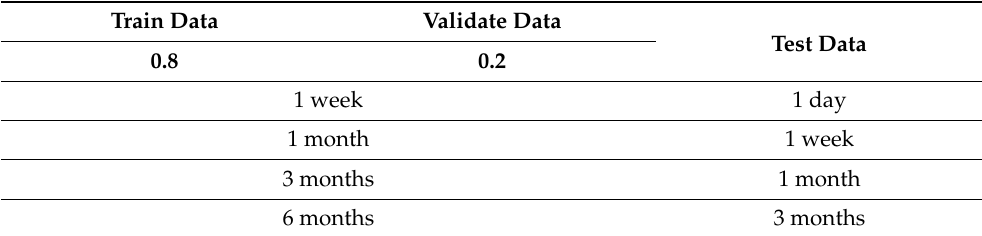
Table 5. Data for verifying the results of the model.